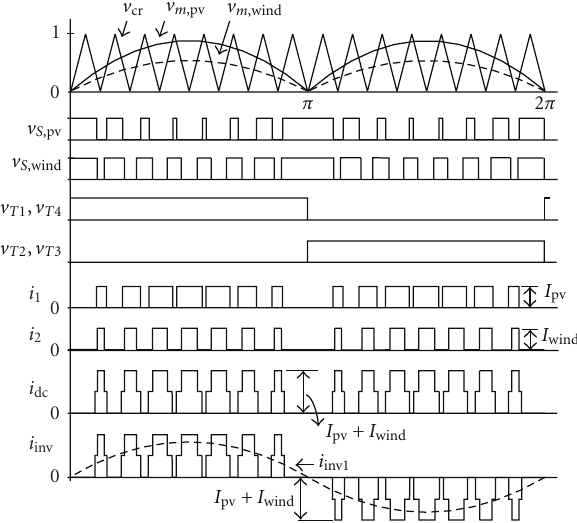
Figure 4: Steady-state waveforms of the proposed grid-connected CSI for hybrid PV/wind